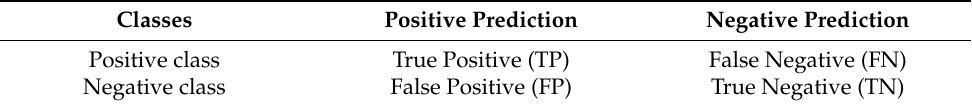
Table 4. Confusion